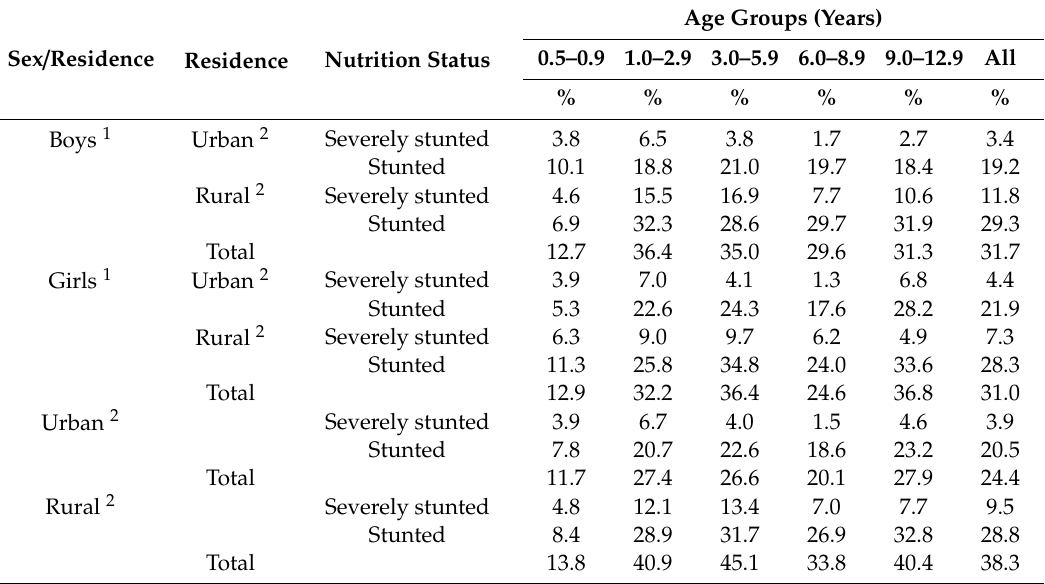
Table 1. Prevalence of stunting by age group, sex and area of residence of Indonesian children.